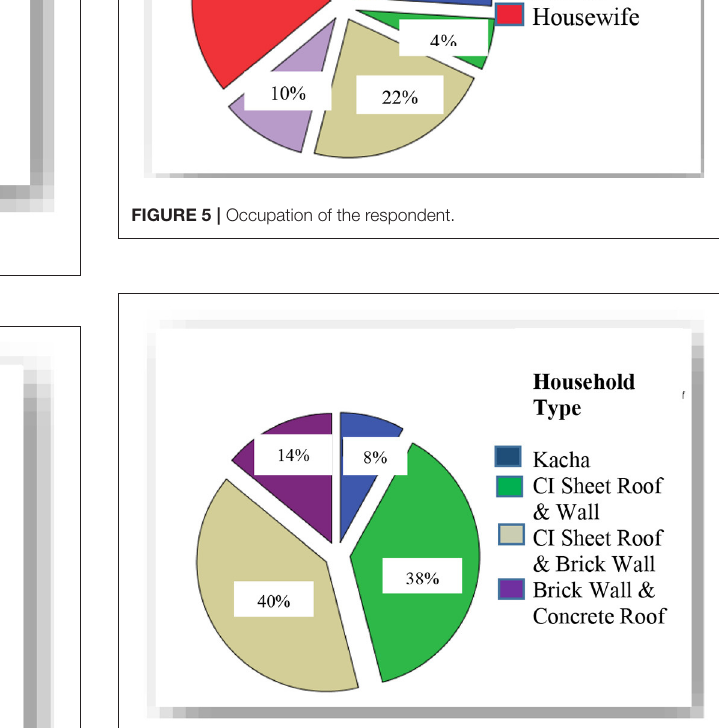
FIGURE 6 | Household